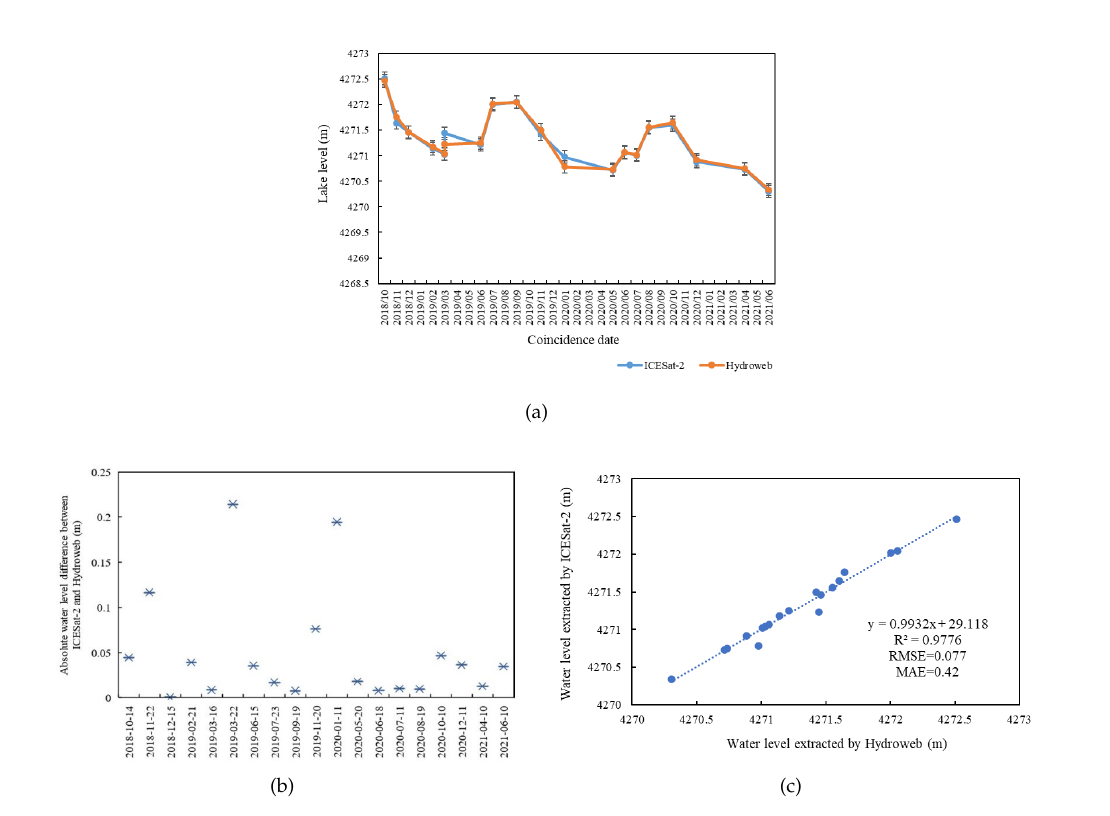
Figure 4. Comparative analysis of water level values extracted by ICESat-2 and Hydroweb. ( a ) Coin- cident date water level of ICESat-2 and Hydroweb; ( b ) Absolute difference of water level values of ICESat-2 and Hydroweb; ( c ) Correlation of water level values extracted by ICESat-2 and